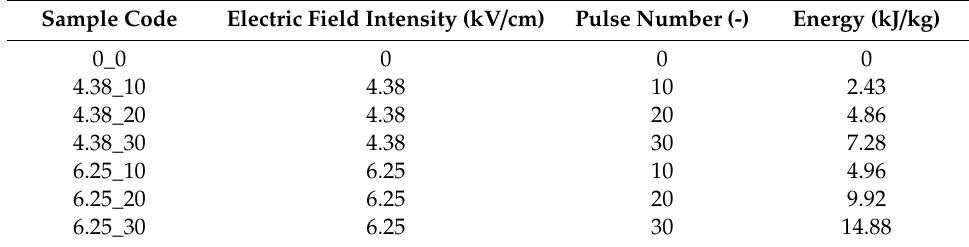
Table 1. Parameters of pulsed electric field (PEF) treatment: electric field intensity, pulse number, and energy delivered to the sample used in the